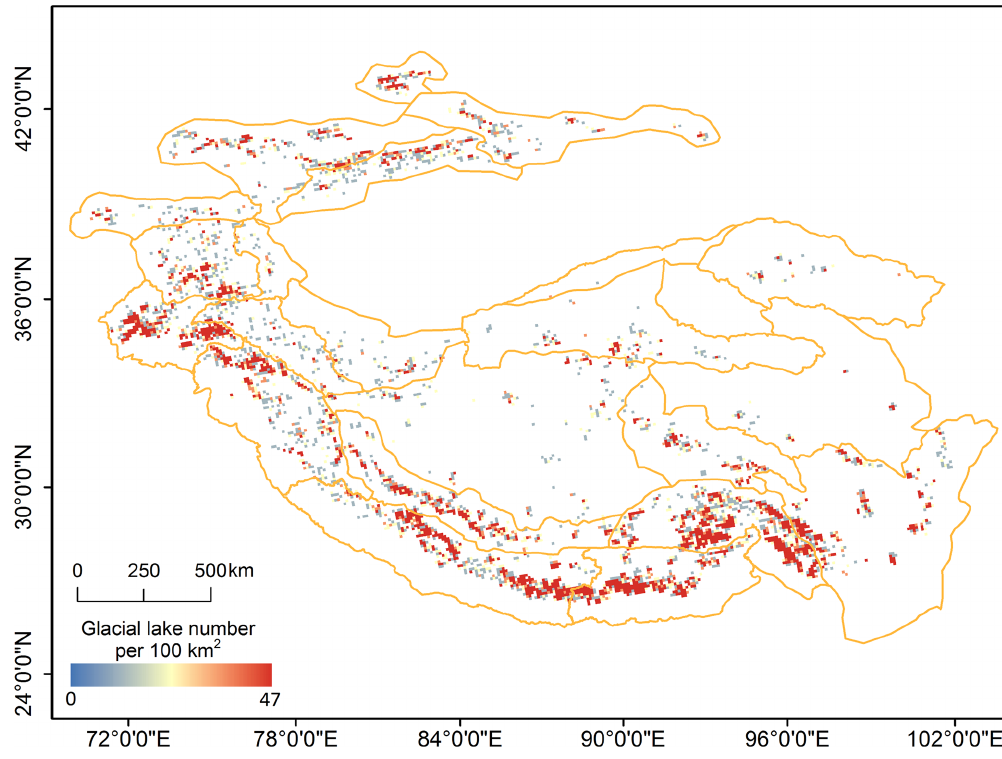
Figure A3. Density (number per 100km 2 ) distribution of glacial lakes in